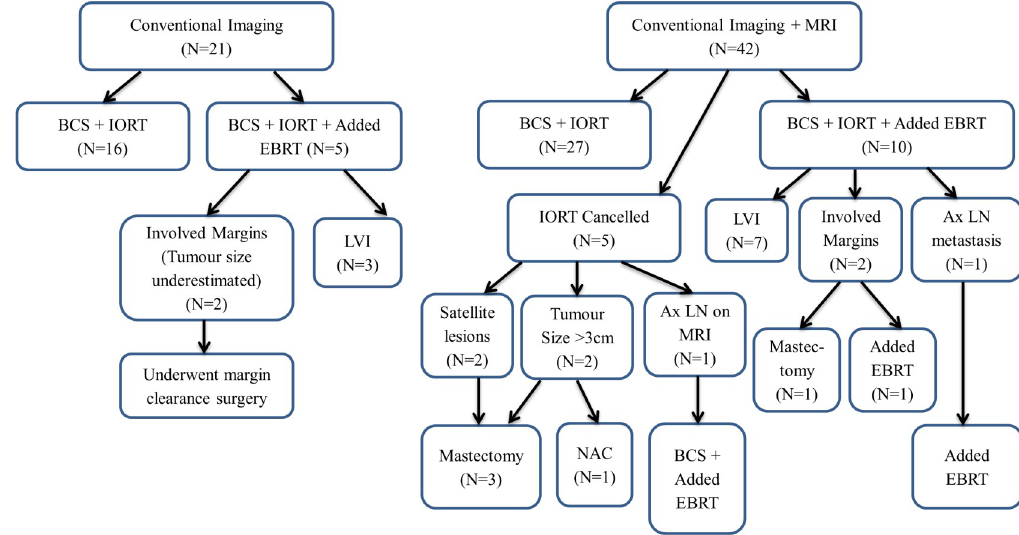
Fig 3. Flowchart outcome for conventional imaging only and conventional imaging plus MRI cohorts. (BCS = Breast- Conserving Surgery, IORT = Intraoperative Radiotherapy, EBRT = External Beam Radiotherapy, LVI = Lymphovascular invasion, Ax LN = Axillary lymph node, NAC = Neoadjuvant chemotherapy).